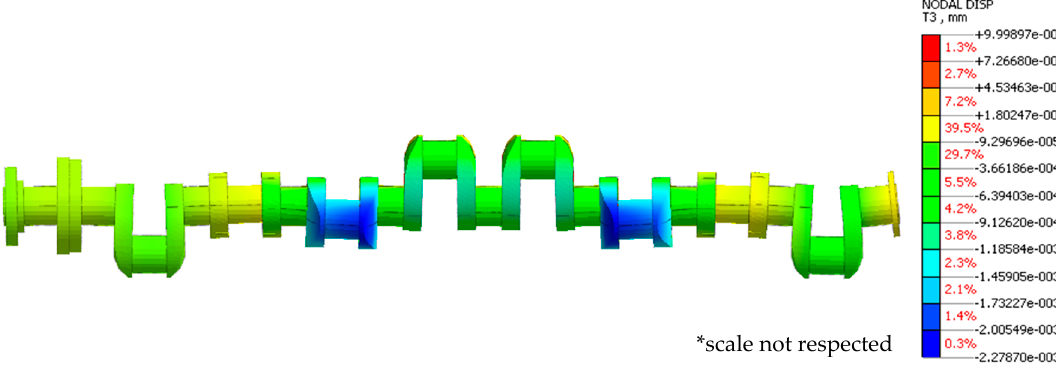
Figure 8. Exemplary finite element analysis results for case 2.